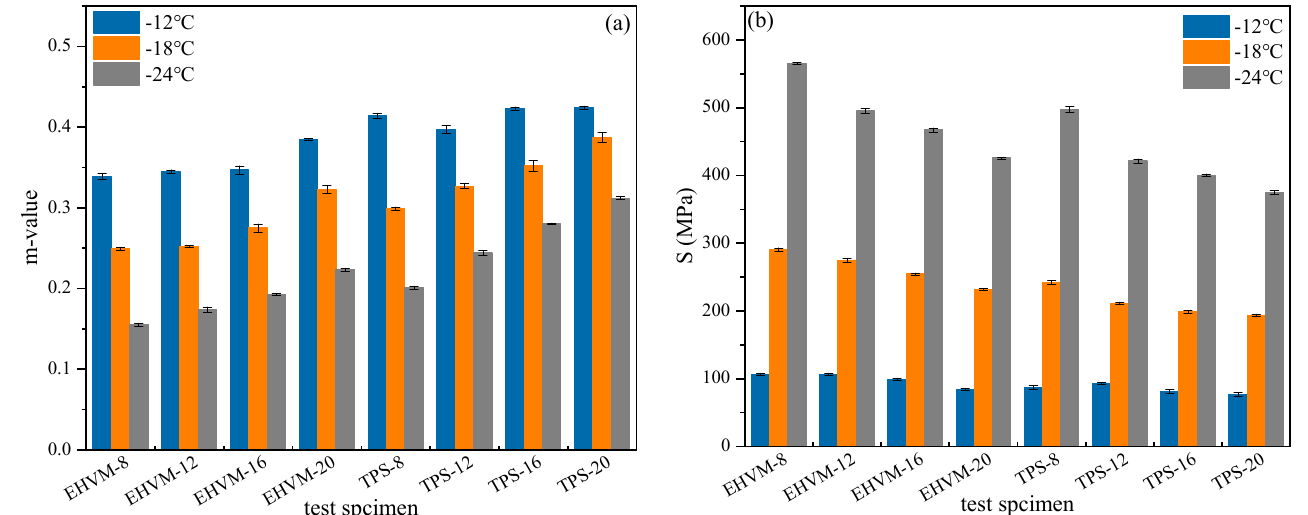
Figure 10. Rheological test results of low-temperature bending beams at different test temperatures: ( a ) Creep rate; ( b ) Creep modulus of stiffness.